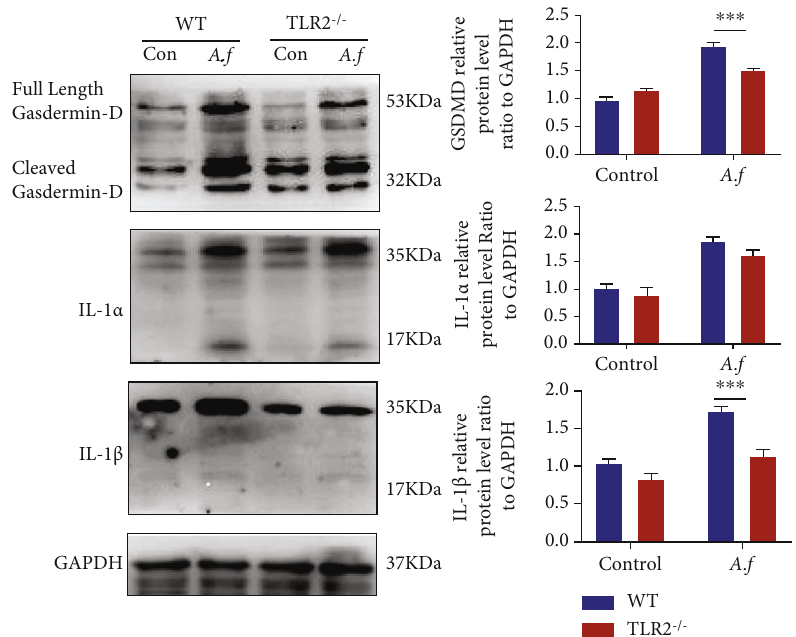
Figure 5: TRL2 signaling involves GSDMD-dependent pyroptosis in Aspergillus fumigatus. The expression of GSDMD, IL-1 α , and IL-1 β protein in lungs was detected by Western blot and analyzed by imager systems described in Section 2 ( n = 3 /group). ns: not signi fi cant; ∗ p < 0 : 05 , ∗∗ p < 0 : 01 , ∗∗∗ p < 0 : 001 , and ∗∗∗∗ p < 0 : 0001 by two-way ANOVA followed by the Tukey post hoc test comparing the WT, WT + A : f : , and TLR2 − / − , TLR2 − / − + A : f : groups. Error bars represent